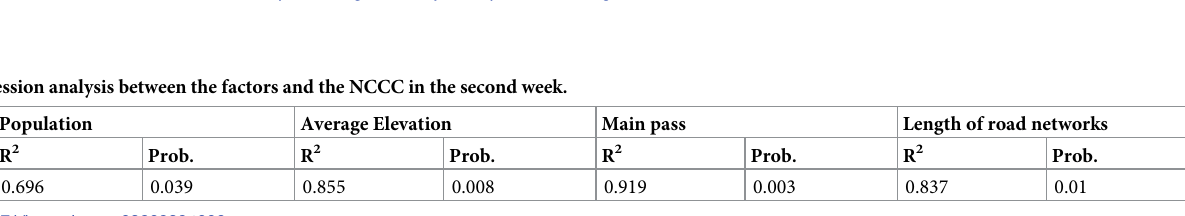
On the basis of research for six provinces around Hubei in the second week, the correlation and regression in national scale was also done to detect it is applicable or not. The main pass factor was excluded firstly because not every province borders Hubei. Following correlation analysis showed that the other three factors were significantly correlated with the number of the confirmed cases ( p < 0.05), especially population ( p < 0.01). The regression results show that the regression equation of average elevation and population is significant ( p < 0.01), but the function of best curve fit is different from that of the six provinces around Hubei (Table 7).